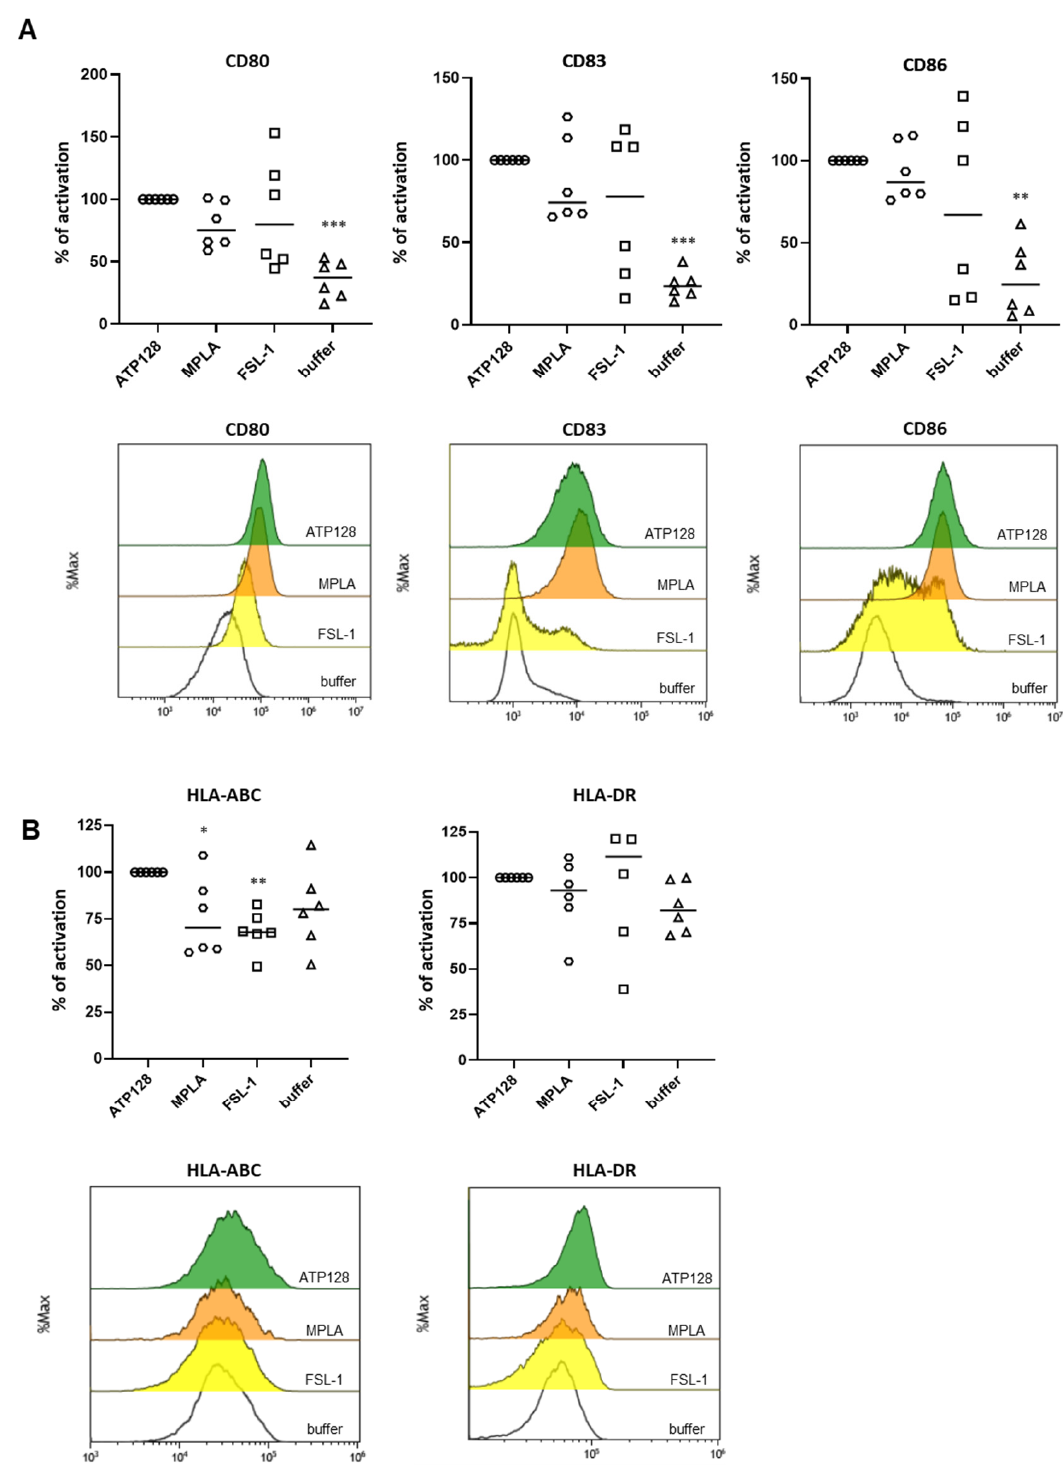
Figure 5. ATP128 activates human moDCs in a profile similar to the TLR4 agonist, MPLA, in an ex vivo system. ( A , B ) Human moDC were incubated for 24 h with 300 nM ATP128 or 600 nM MPLA or 1 ng/mL FSL-1. Cells were collected after stimulation and surface costimulatory molecules ( A ) and HLA class I and class II molecules ( B ) were analyzed through flow cytometry. Each shape is representative of a different buffy coat. Histograms of one representative buffy coat are shown be- low. Values were compared via one-way ANOVA test to the sample stimulated with ATP128 FL., *** p -value < 0.001, ** p -value < 0.01, * p -value < 0.05. Cytokines secreted by human moDCs were assessed upon stimulation with the KI- SIMA vaccine. After a 6 h stimulation of moDCs with ATP128 in the presence or absence